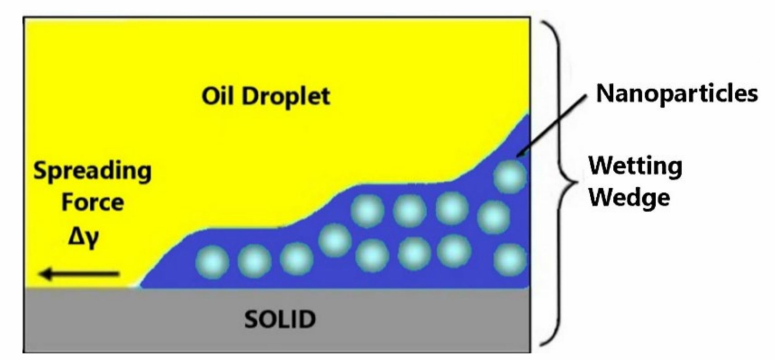
Figure 4. Nanoparticles in a wedge-film structure. Source: M. Adil, et al. [60] reprinted with